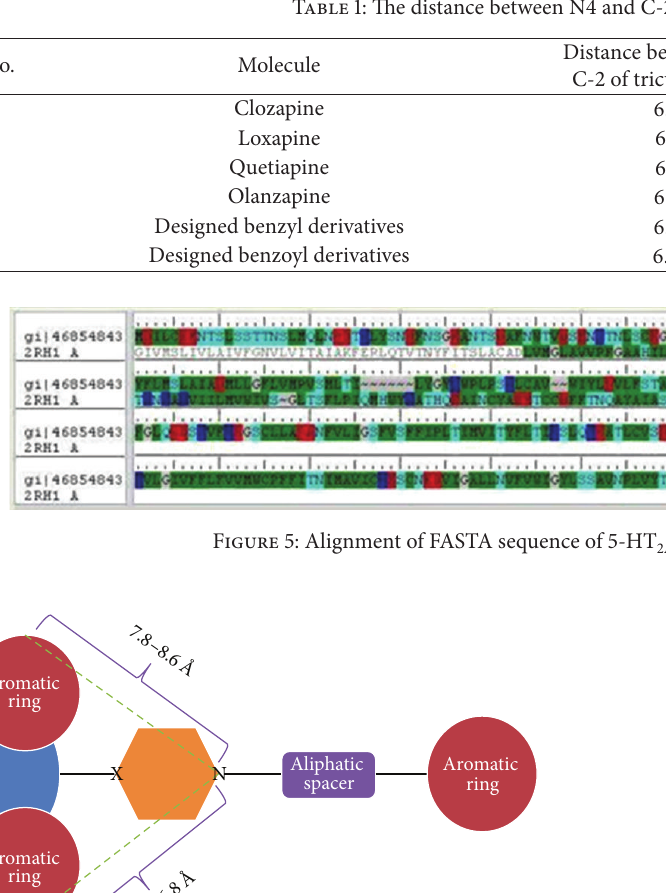
Figure 7: General structure of designed library used for further